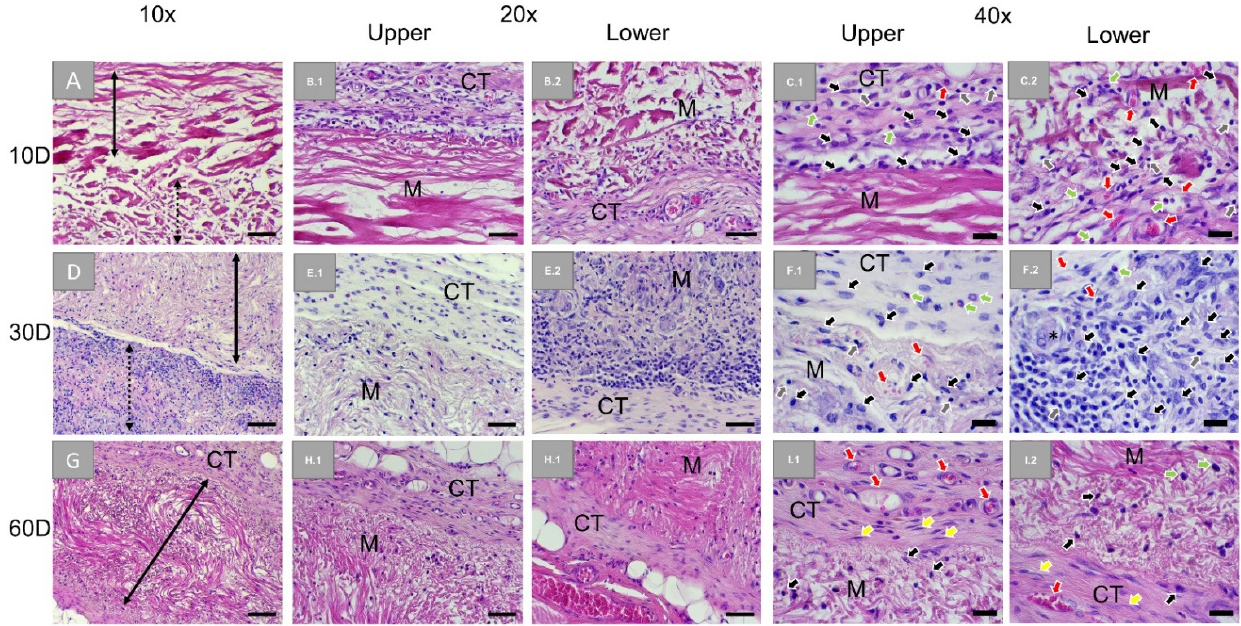
Figure 3. Exemplary histological images of subcutaneously implanted collagen-based bilayer barrier membrane (Bio- Gide ® ) at three timepoints: 10 days (first row: A , B.1 , B.2 , C.1 , C.2 ), 30 days (second row: D , E.1 , E.2 , F.1 , F.2 ), and 60 days (third row: G , H.1 , H.2 , I.1 , I.2 ). Stretched black arrow: compact layer of the membrane, stretched dotted arrow: loose layer of the membrane, CT: connective tissue, M: membrane, black arrows: macrophages, red arrows: blood vessels, green arrows: granulocytes, grey arrows: lymphocytes, yellow arrows: fibroblasts (HE-stainings, 10 × , 20 × , and 40 × objective magnifications with scale bars: 100 µ m, 50 µ m, and 20 µ m, respectively).